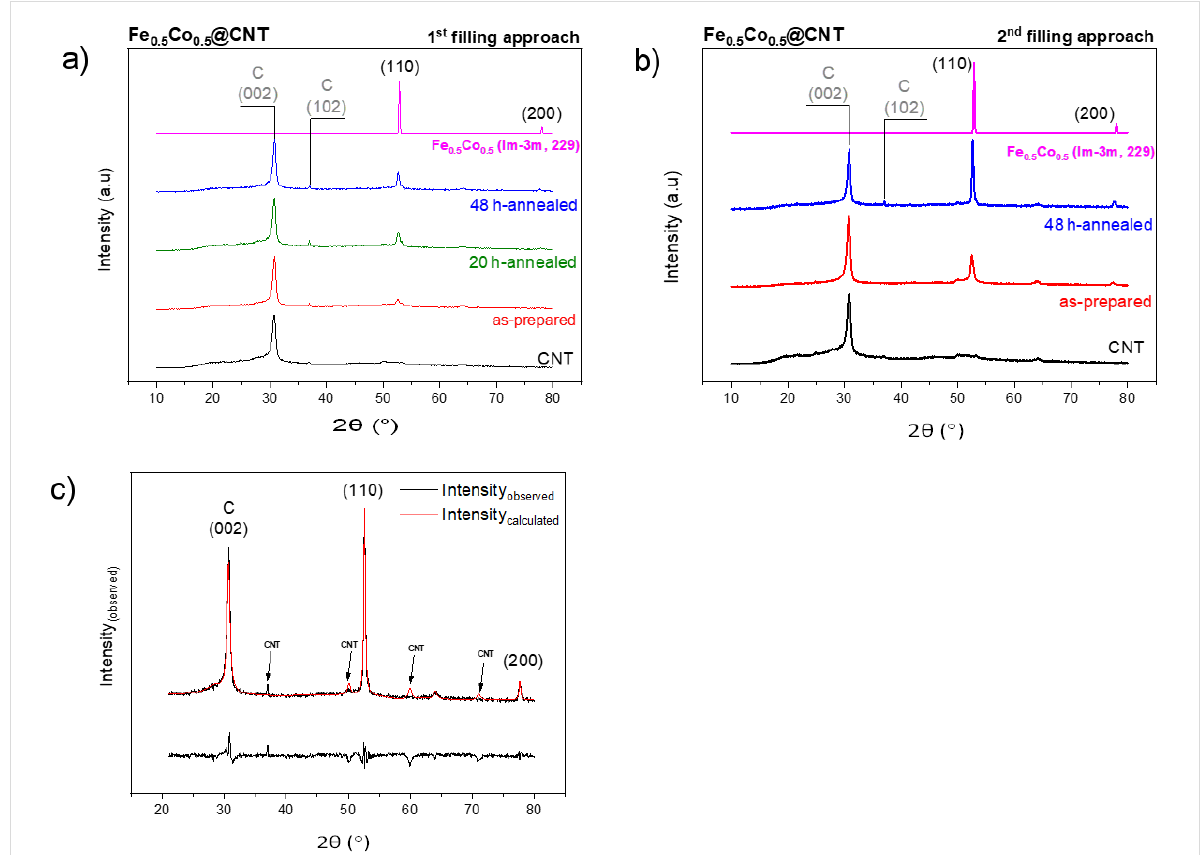
Figure 5: XRD diffraction patterns for the as-prepared and annealed samples of Fe 50 Co 50 @CNT prepared by the a) first (solution) and b) second ap- proach. c) Rietveld refinement for the annealed Fe 5 0 Co 50 @CNT sample prepared by the second approach.